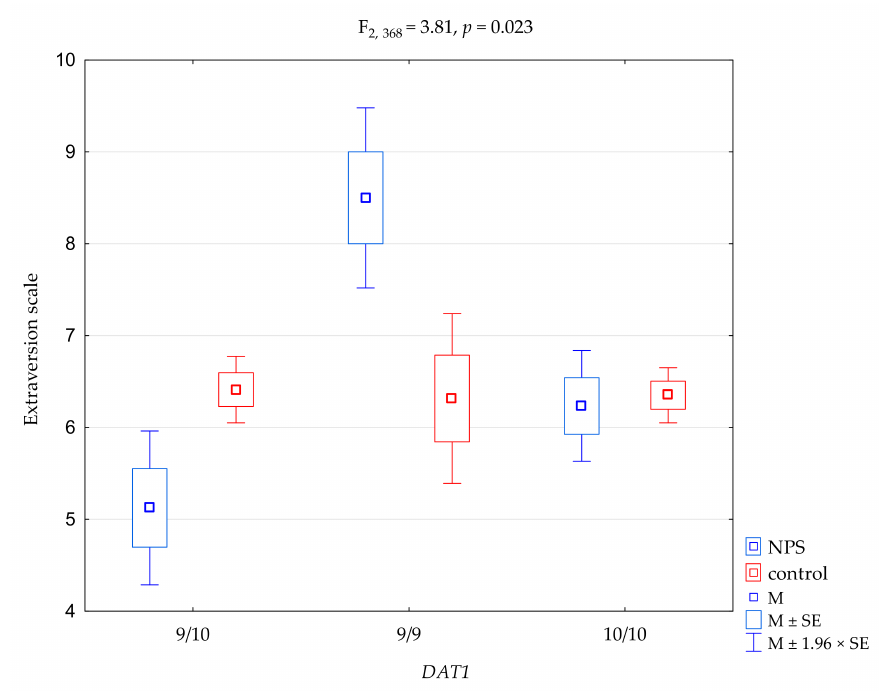
Figure 2. Interaction between users of ‘new psychoactive substances’ (NPS)/controls, DAT1 poly- morphisms, and the NEO-FFI extraversion scale. M, mean; SE, standard